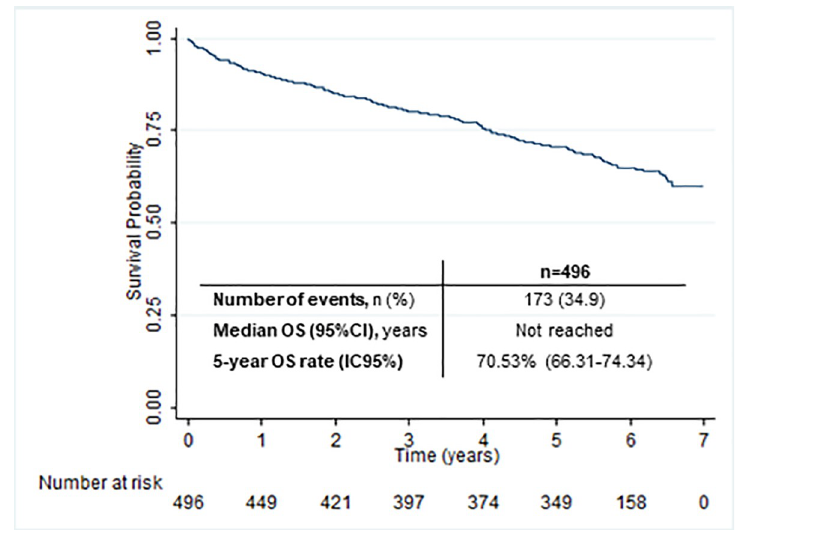
Fig 2. Kaplan-Meier estimate for OS.